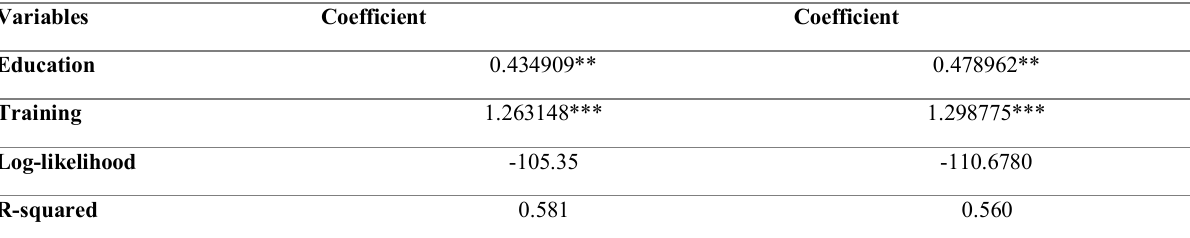
Table 2: Results of probit estimation for initial model and with omitted